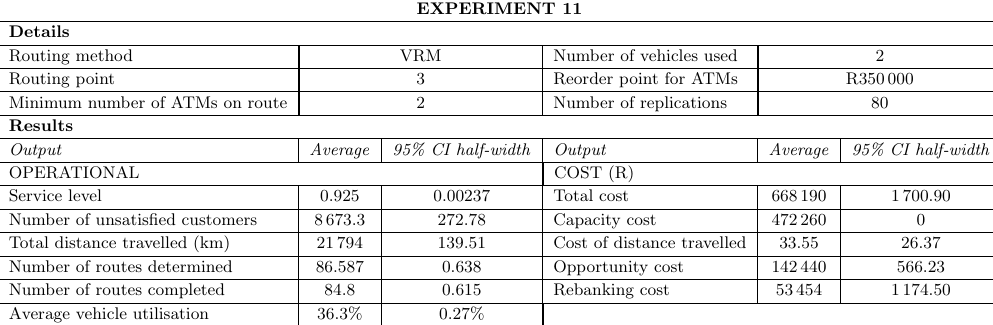
shown under “Details”. The point estimators of the various output parameters are shown with 95% confidence intervals.